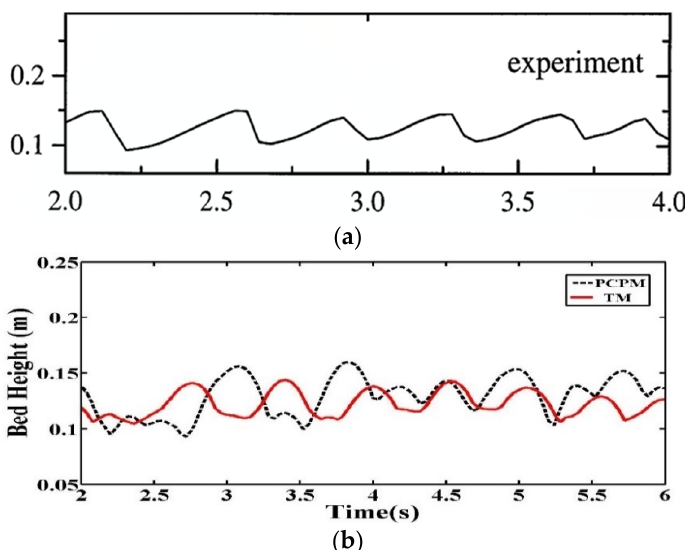
Figure 6. Pressure drop at the 45 mm horizontal section above the fluidized bed distributor. ( a ) experimental result given by Van Wachem et al. [18] (reused with permission from Elsevier); ( b ) simulation results.